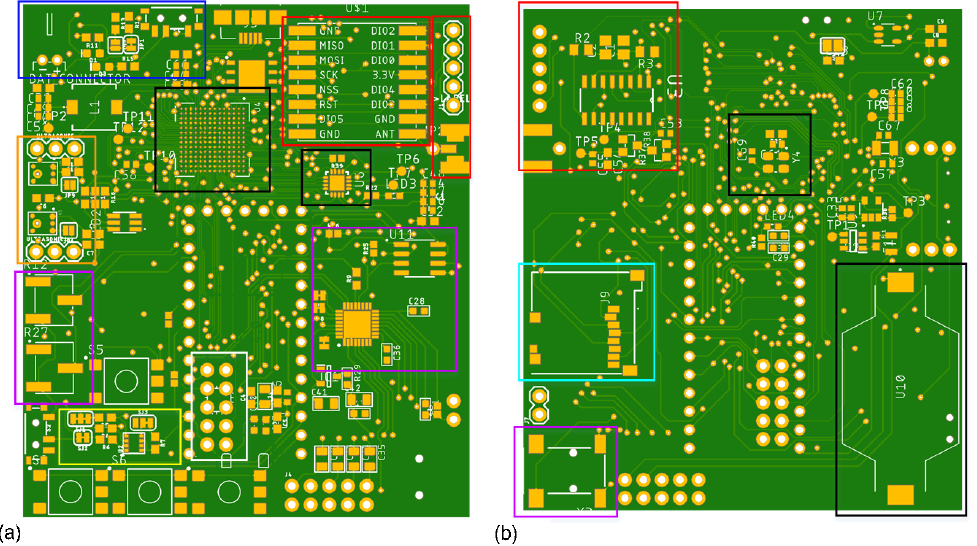
Figure 2. Multipurpose print circuit board sensor and the highlight modules. Red: LoRa module; Black: bootloader, microcontroller core and real-time clock (RTC); Blue: battery module; Orange: Microphone slots and modules; Cyan: microSD module; Yellow: environmental data module; Purple: audio module and controllers; White: Optical slots. ( a ) Top layer. ( b ) Bottom